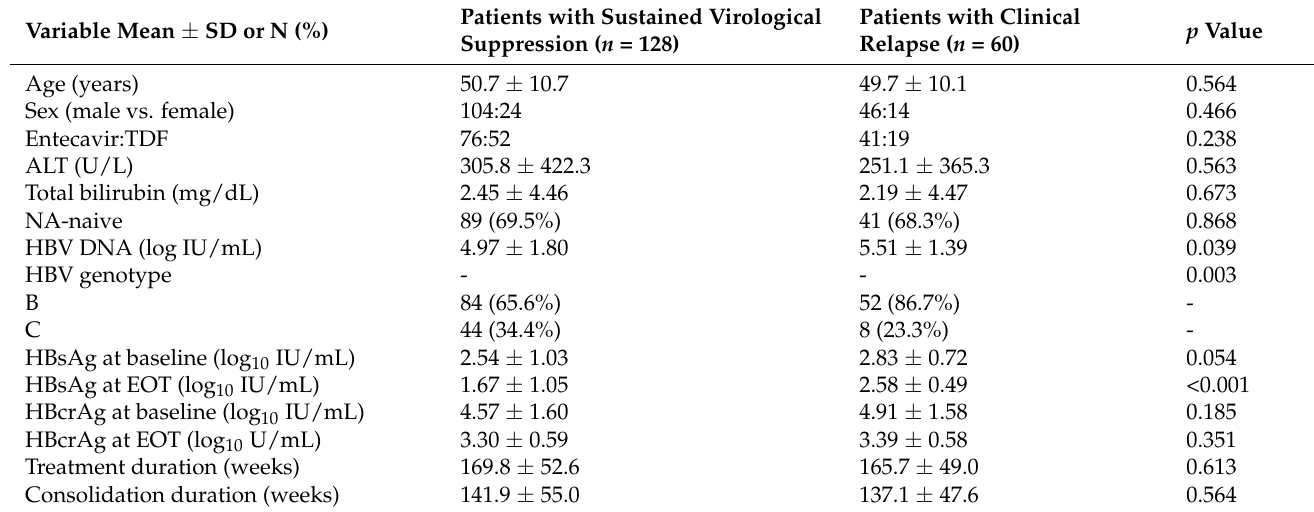
Table 6. Clinical features of patients who had persistent virological remission without (Group I) or with (Group V) clinical relapse.